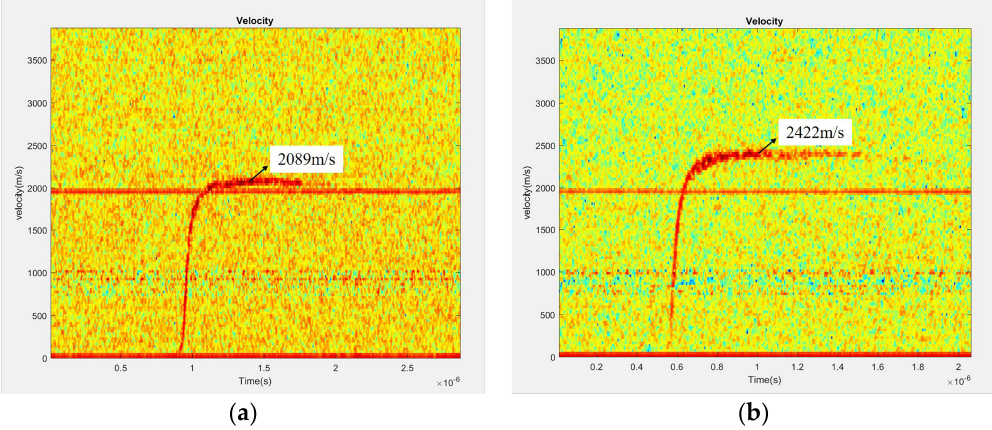
Figure 9. Flyer velocity curves measured by PDV at ( a ) 1100 V/0.22 μF; ( b ) 1200 V/0.22 μF.